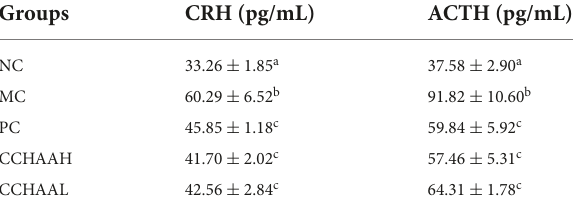
TABLE 2 The effects on the secretion of plasma hypothalamic-pituitary-adrenal (HPA) axis ( n = 12). Groups